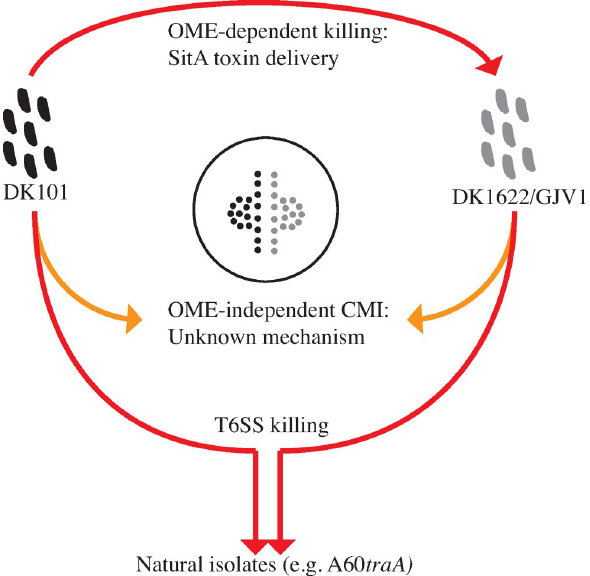
Fig 7. Model of known and proposed interactions and relationships among DK101, DK1622 and GJV1. DK101 kills DK1622 and GJV1 due to OME delivery of SitA toxins ([26, 46] and Fig 1). A CMI boundary forms between colonies of DK101 and GJV1 (and by inference DK1622) that is not caused by OME-delivered Sit toxins (Fig 2). DK101, DK1622 and GJV1 are proposed to kill (and thus inhibit swarming by) natural isolates (and traA mutants of such isolates) due to a shared T6SS (Fig